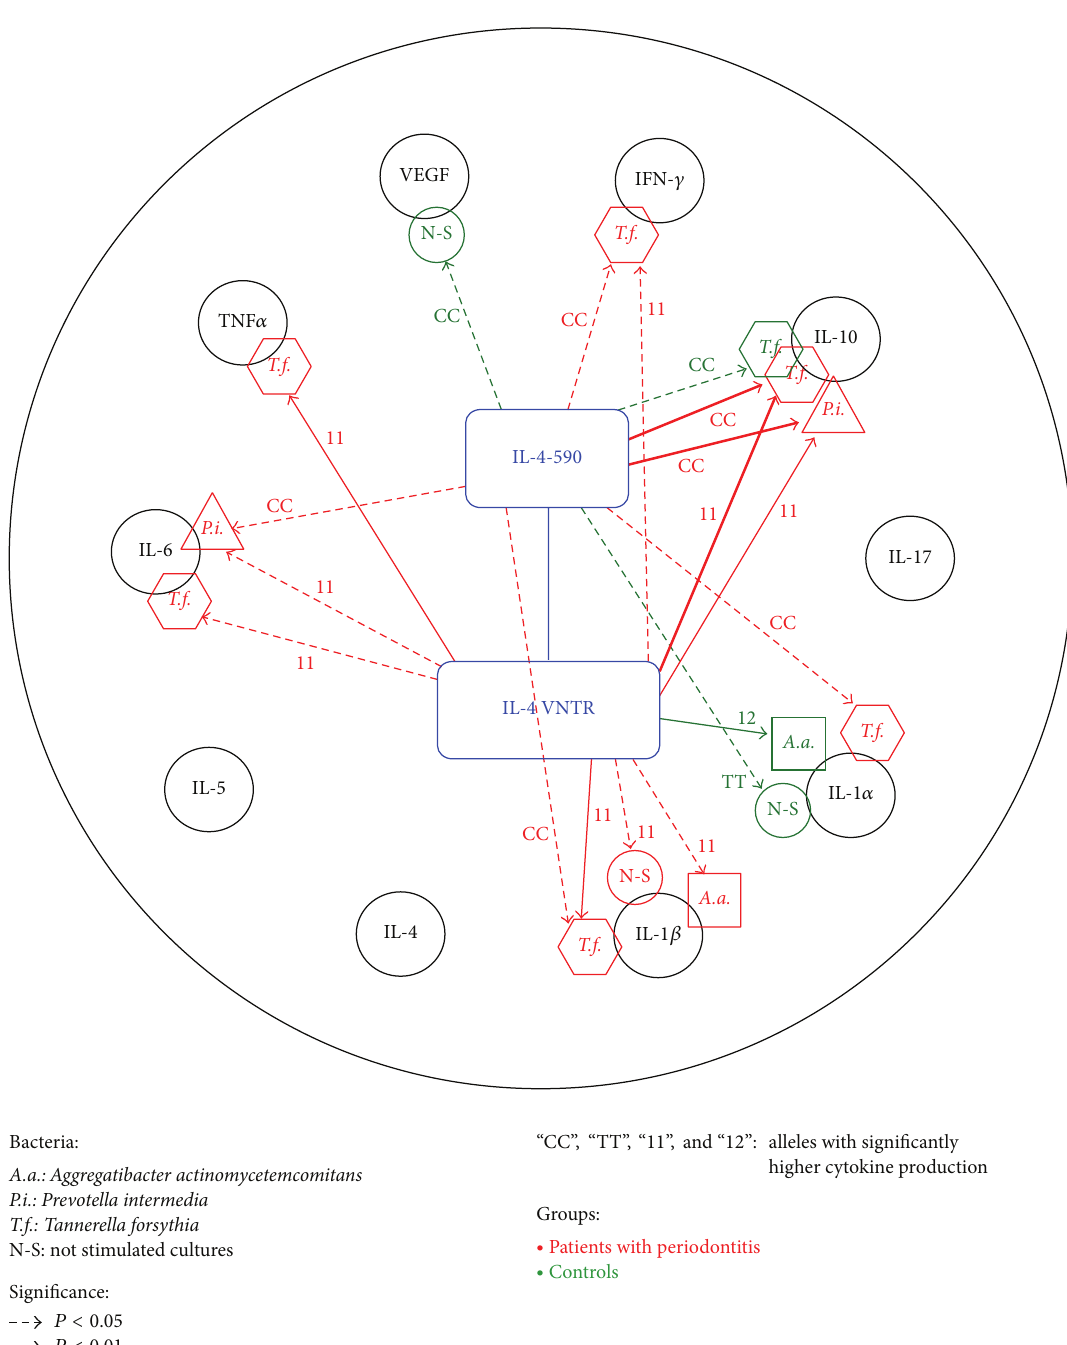
Figure 1: Statistically significant (higher) production of cytokines (unstimulated and stimulated by bacteria) on alleles of IL-4 SNP genes for patients with periodontitis ( 𝑁 = 47 ) and healthy controls ( 𝑁 = 15 ), evaluation by Spearman rank correlations. Remark: our application of Spearman correlation analysis gives us the very similar results in comparison with levels of significance observed by K-W method with preliminary aggregation of two adjacent minority alleles (see legend under Table 3); application of Spearman rank correlations does not reduce any data and slightly more supports the hypotheses related to expression of cytokines on homozygous